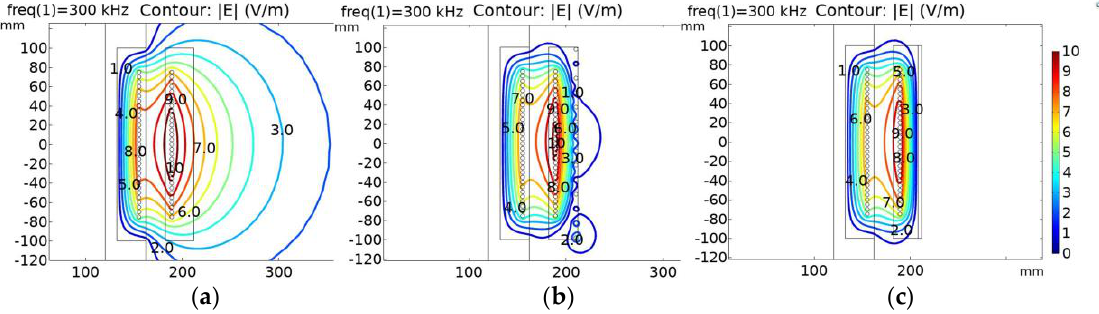
Figure 10. The distribution of the electric field: ( a ) the system without shield; ( b ) the system with a shielding coil; and, ( c ) the system with a metallic plate as shield.